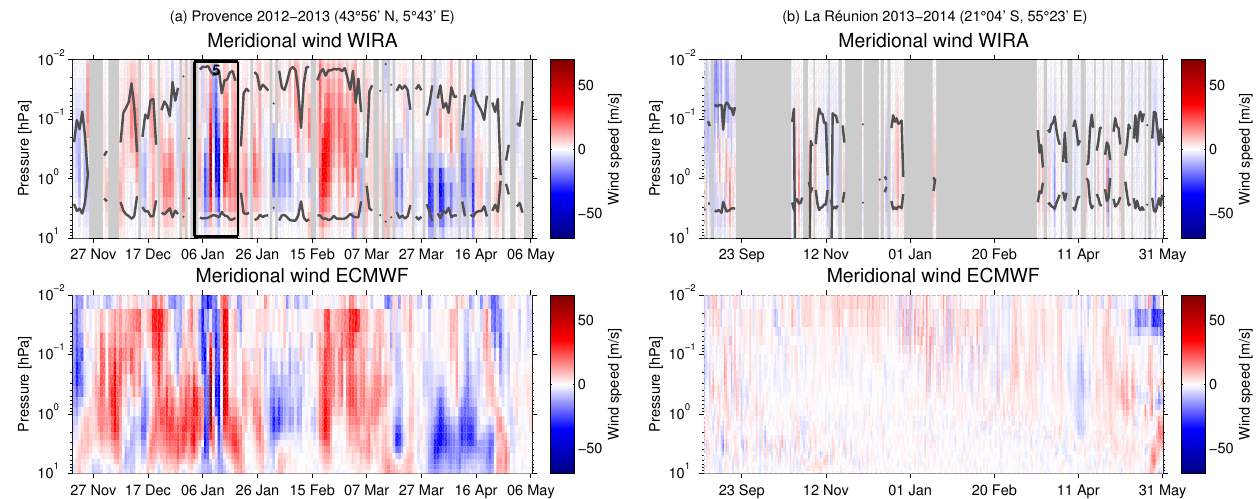
Figure 15. Meridional wind time series measured by WIRA at two different locations compared to ECMWF operational analysis data. The grey lines delimit the trustable altitude range of the retrieved data. The black rectangle marks a dynamic episode described in the text.